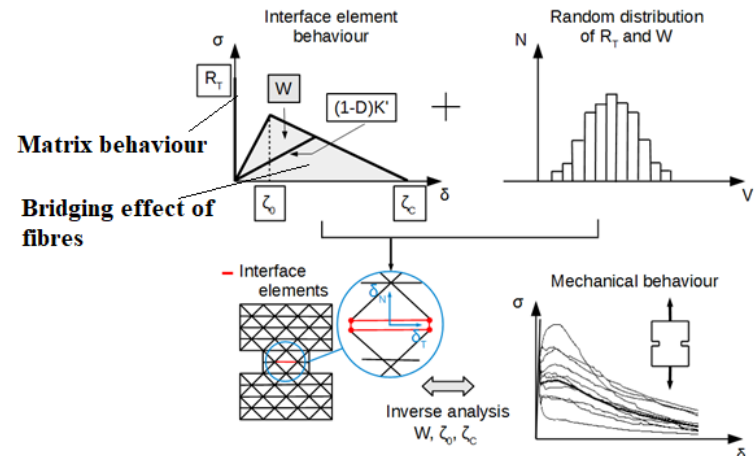
Figure 1. Probabilistic explicit cracking model for FRC.